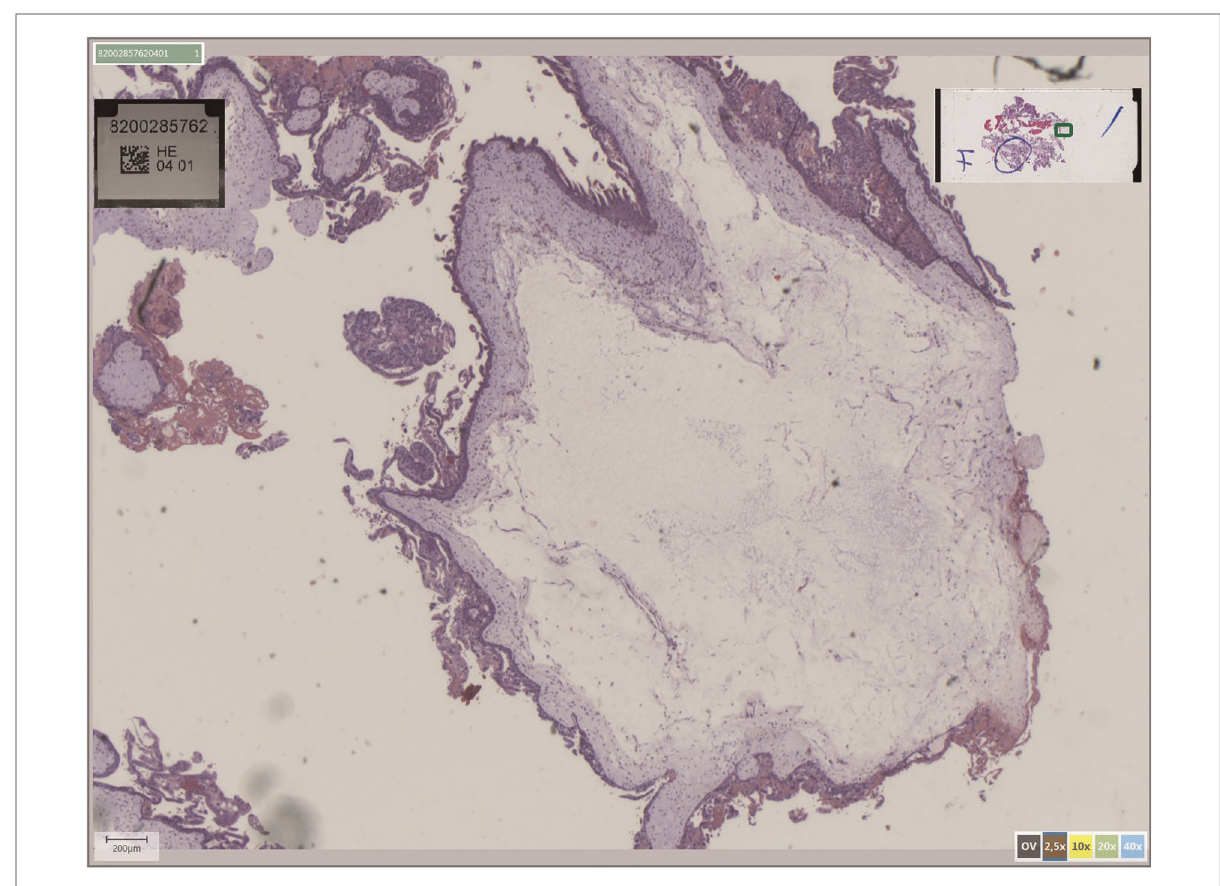
FIGURE 4 Pathology of the complete tubal hydatidiform mole: degeneration of chorionic villi around a central hydropic lacuna along with trophoblast development due to fertilization of the abnormal ovum de fi nes the hydatidiform